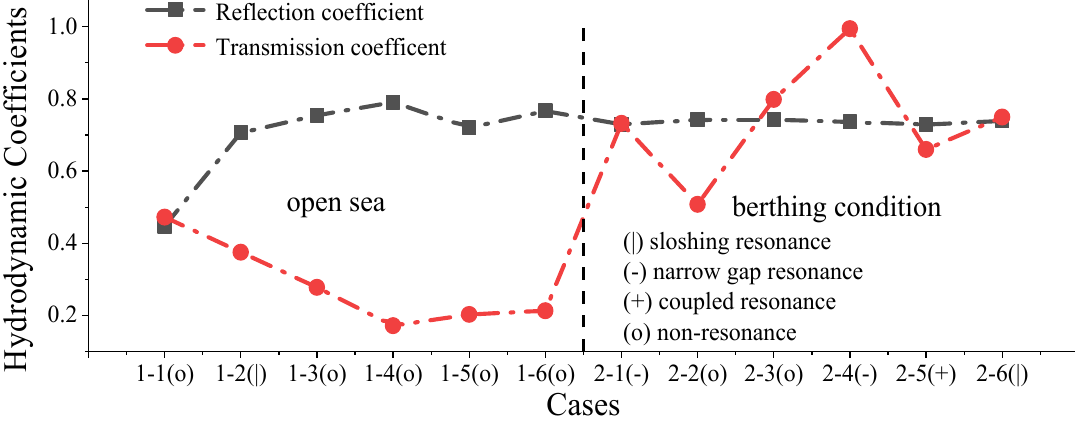
Figure 4. Transmission and reflection coefficients of the floating tank.